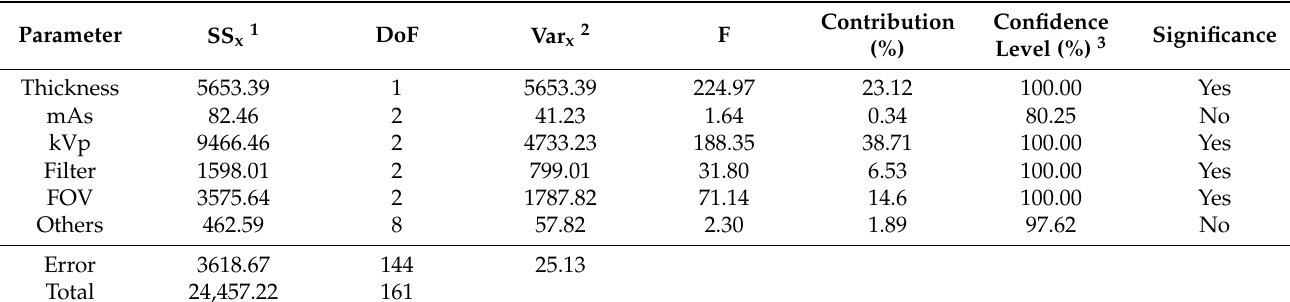
1 SS x : The sum of the square of a specific parameter. confidence